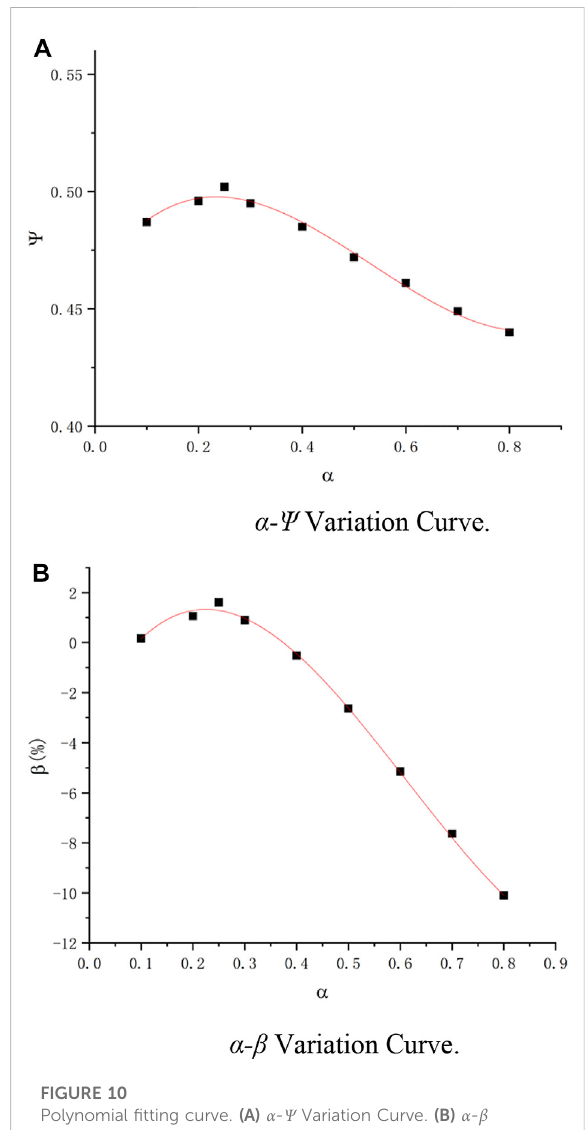
FIGURE 10 Polynomial fi tting curve. (A) α - Ψ Variation Curve. (B) α - β Variation